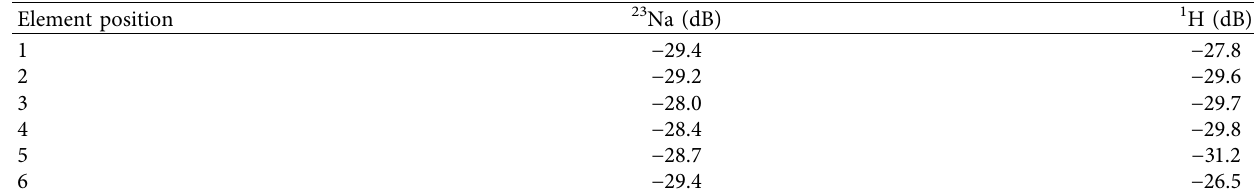
Figure 6: Double-tuned feld maps (a) Axial feld map for 1 H coil normalized to show feld variation with a black box highlighting the food region of the phantom. (b) Axial feld map for sodium coil normalized to show feld variation with black box highlighting the food region of the phantom. (c) Axial phase map of the 1 H coil normalized to show phase variation in degrees from the center of the coil with black box highlighting the food region of the phantom. (d) Axial phase map of the sodium coil normalized to show phase variation in degrees from the center of the coil with black box highlighting the food region of the phantom. Table 3: Double-tuned birdcage-surface coil decoupling measurements.